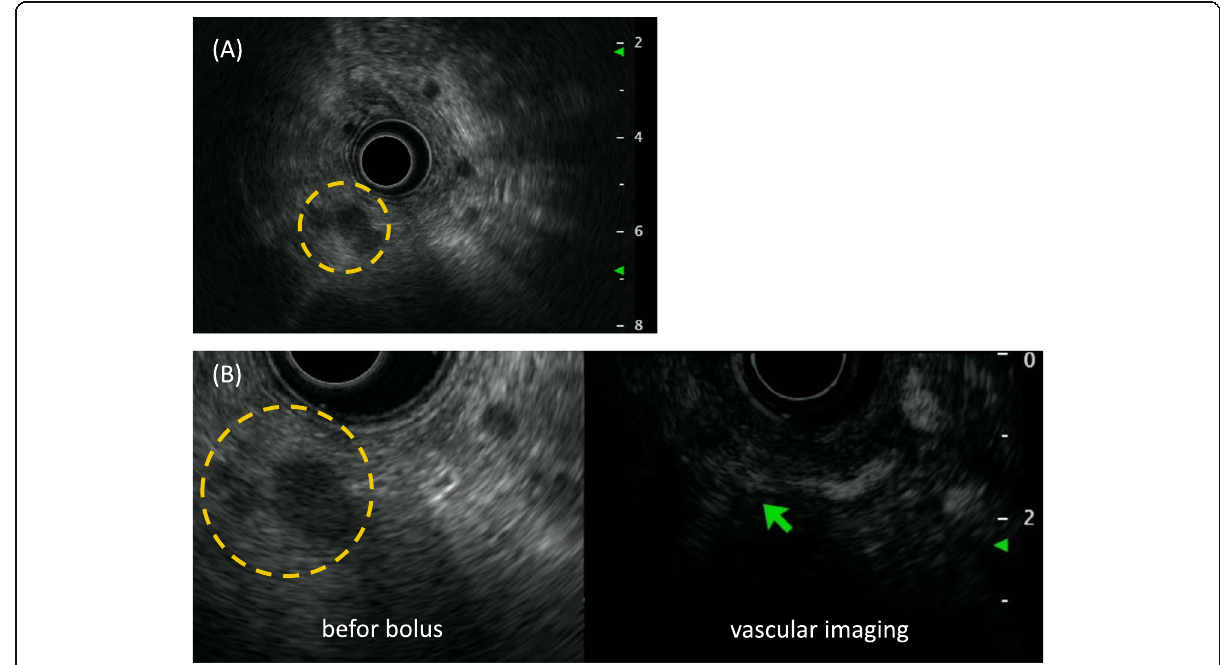
Fig. 1 Endoscopic ultrasound findings. a Endoscopic ultrasound showed a low-density mass measuring about 16 mm in size in the pancreatic tail (circle). b The low-density mass in the pancreatic tail was partially enhanced on the contrast-enhanced ultrasound with bolus